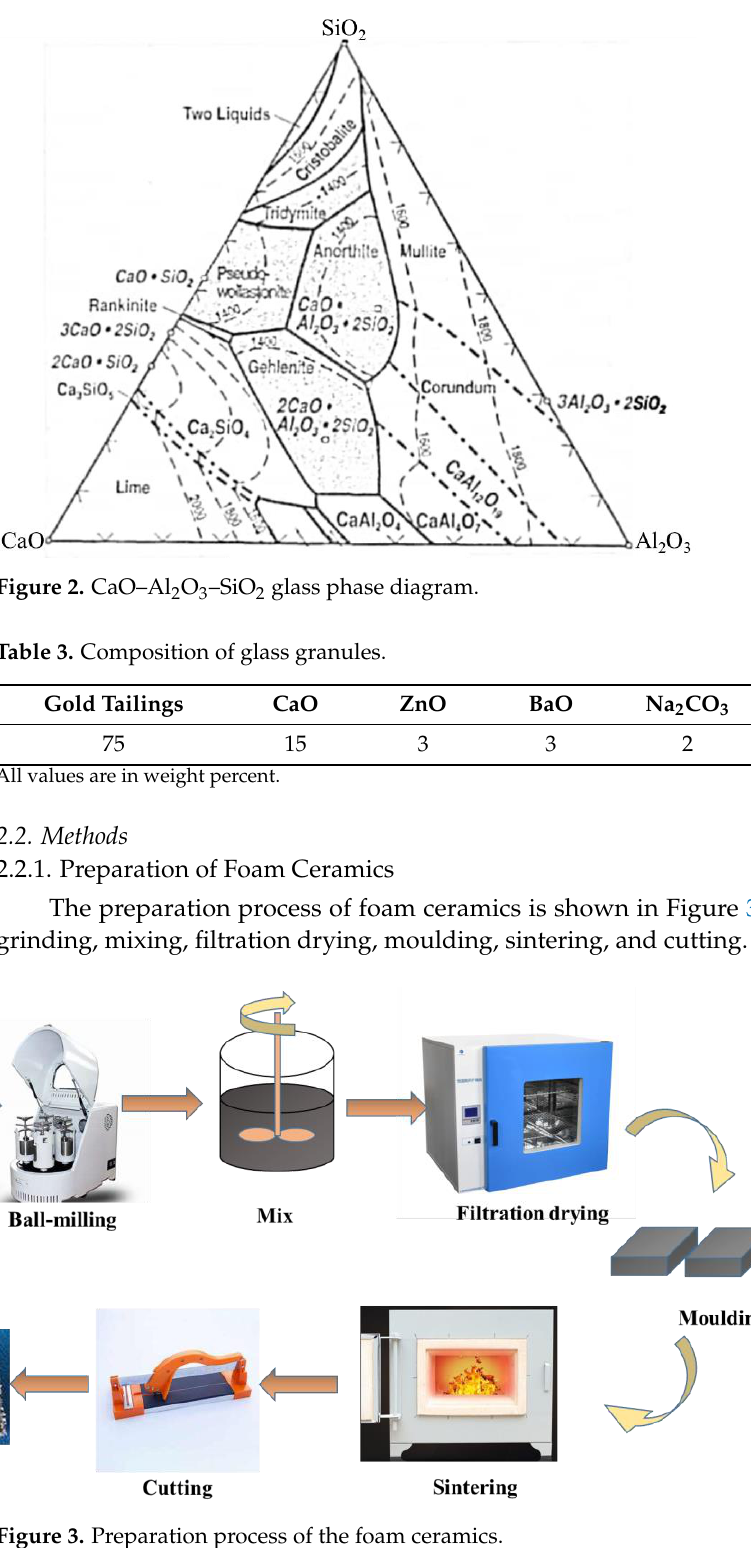
Figure 4. Glass granules. 2.3. Preparation of Microcrystalline Foam Ceramics The method for preparing microcrystalline foam ceramics is to add glass granules to the original foam ceramics. The ratio of raw materials for preparing microcrystalline foam ceramics is shown in Table 4. For the samples with glass granules, the crystallisation tem- perature in the sintering process needs to be reduced to achieve the appearance or me- chanical properties similar to those of foam ceramics. The higher the content of glass par- ticles, the lower the crystallisation temperature. None of the samples could be foamed at 1000 °C. In addition, there were 4 samples that could be made with a good foamed state, which were S6(1-1) at 1190 °C, 1-2 at 1150 °C, 2-3 at 1100 °C and 3-4 at 1050 °C.